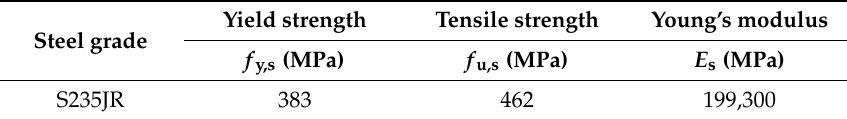
Table 1. Measured mechanical properties of the steel.